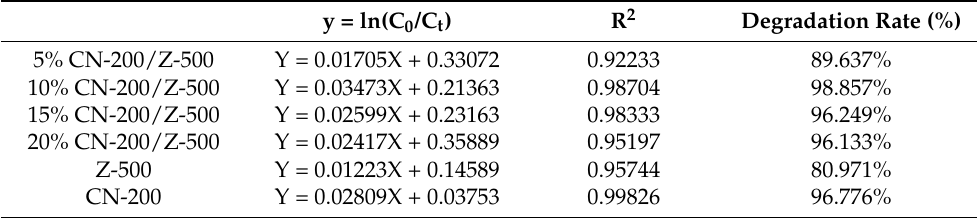
Table 2. Degradation rates of MB with different